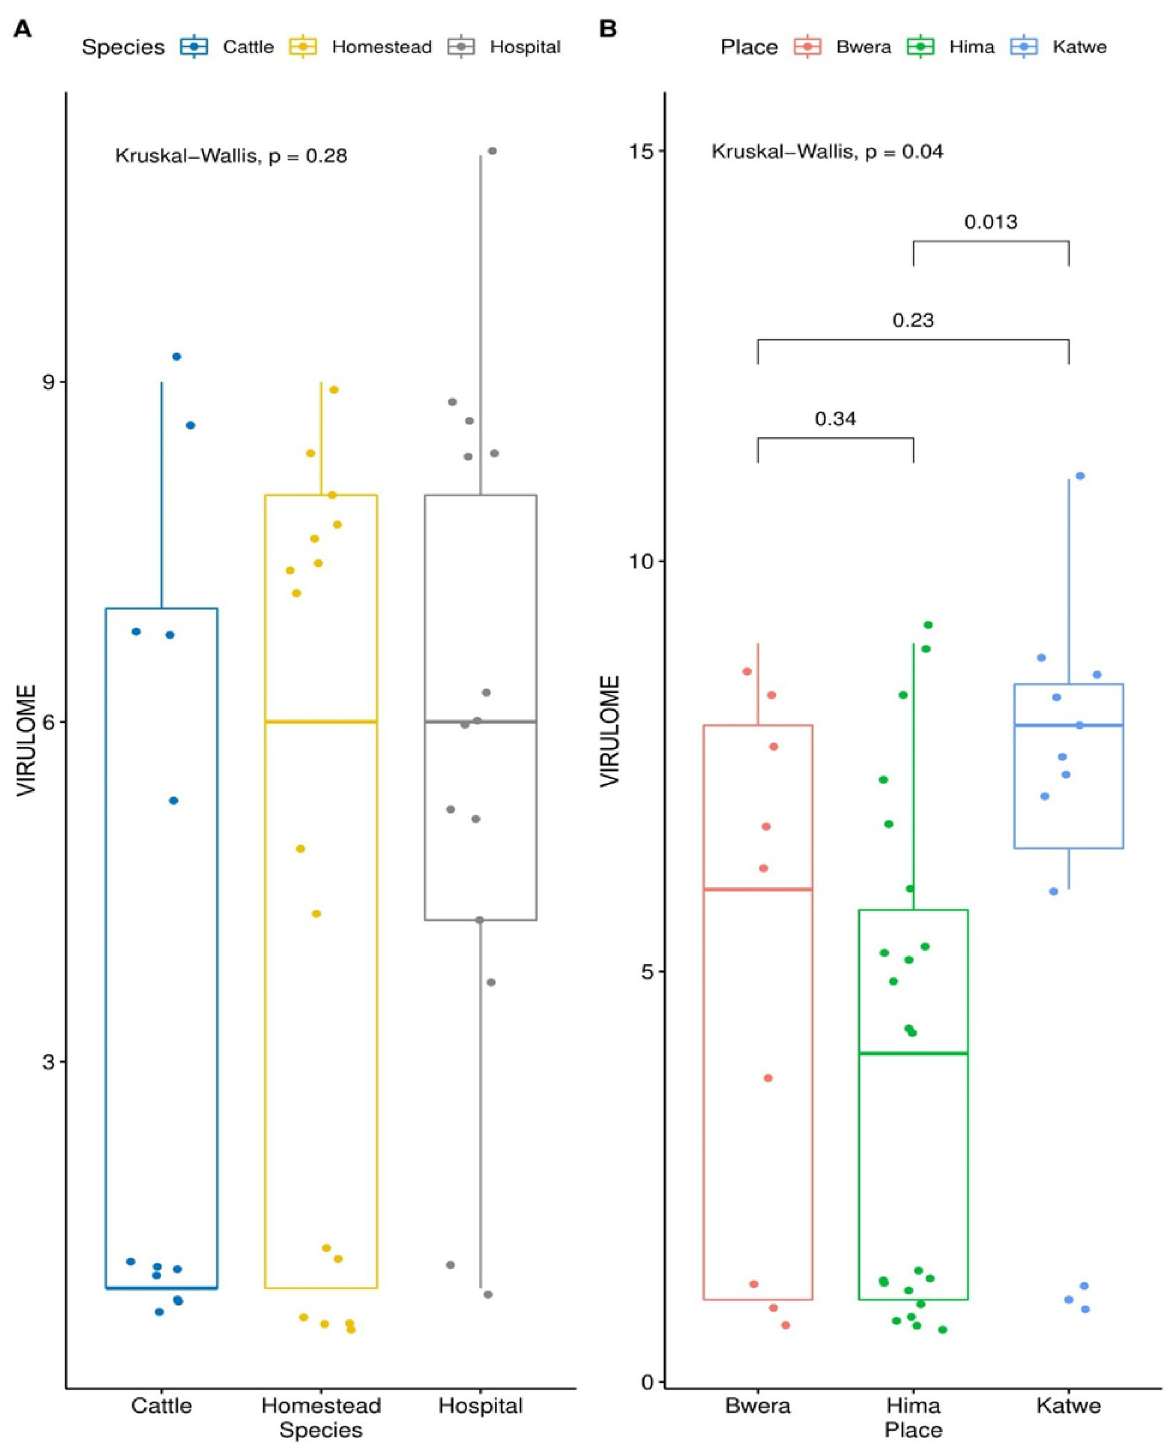
Fig 4. Box plots comparing the variation in virulence of the E . coli from hospital and the community. Homestead = community isolated E . coli , species =